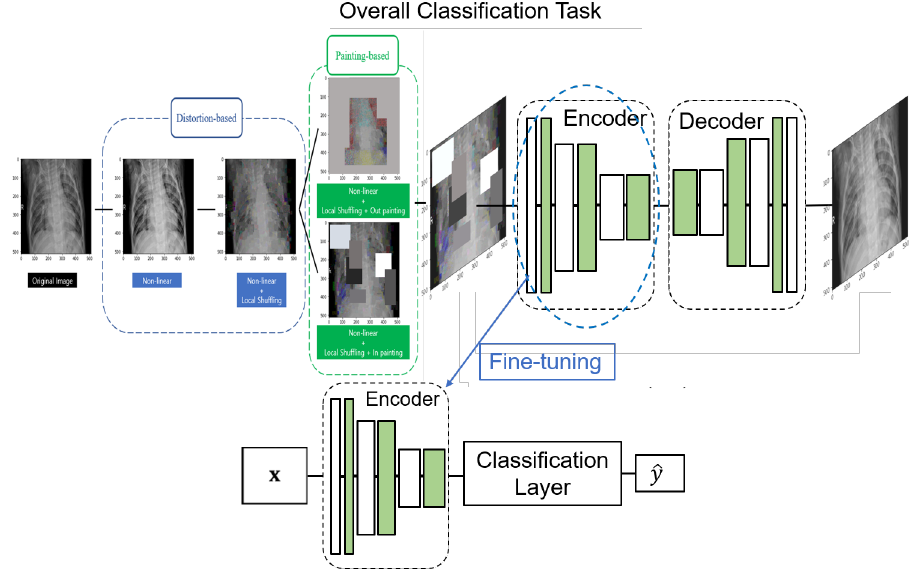
Figure 5. Our overall proposed